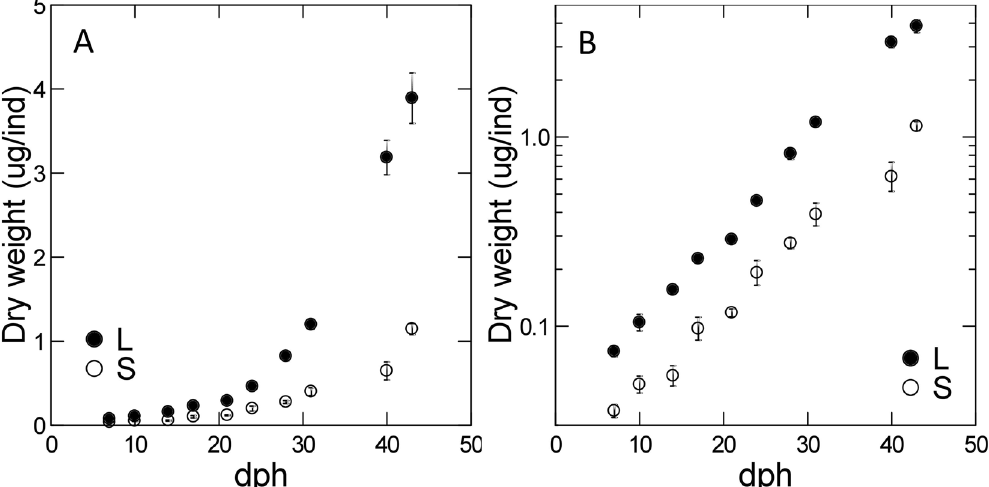
Figure 1. Size development of small (S) and large (L) cod larvae during the experimental period of 42 days presented as average dry weight per individual. ( A ) original data; ( B ) data in logarithmic weight-axis. Error bars are standard error for 5